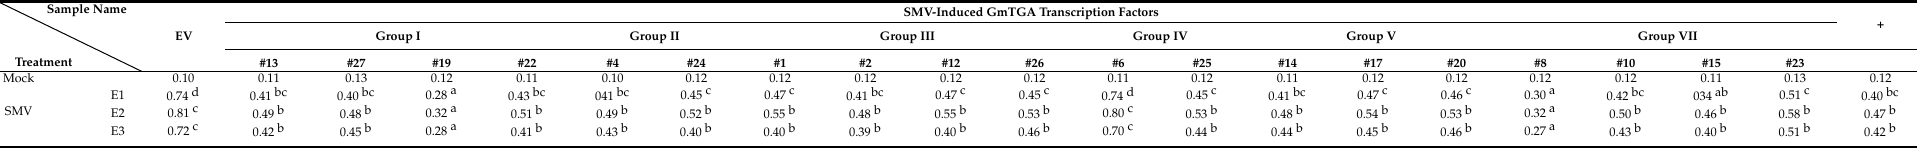
The different letters a, b, c and d represent the significance of the ELISA means at p = 0.05 level among treatments in a same row; Mock: 0.01 M phosphate buffer inoculation as control; SMV: isolate 4278-1; E1, E2 and E3: biological repeat 1, 2 and 3; EV: empty vector; #13, 27, 19, 22, 4, 24, 1, 2, 12, 26, 6, 25, 14, 17, 20, 8, 10, 15, and 23: overexpression construct of different GmTGA genes; +: overexpression construct of SMV coat protein gene; dpi: days